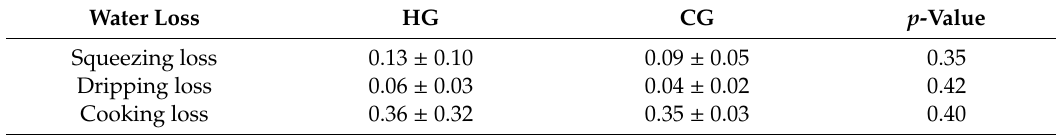
Table 9. E ff ect of gentle handling on water loss of meat (mean ± standard deviation) ( p <